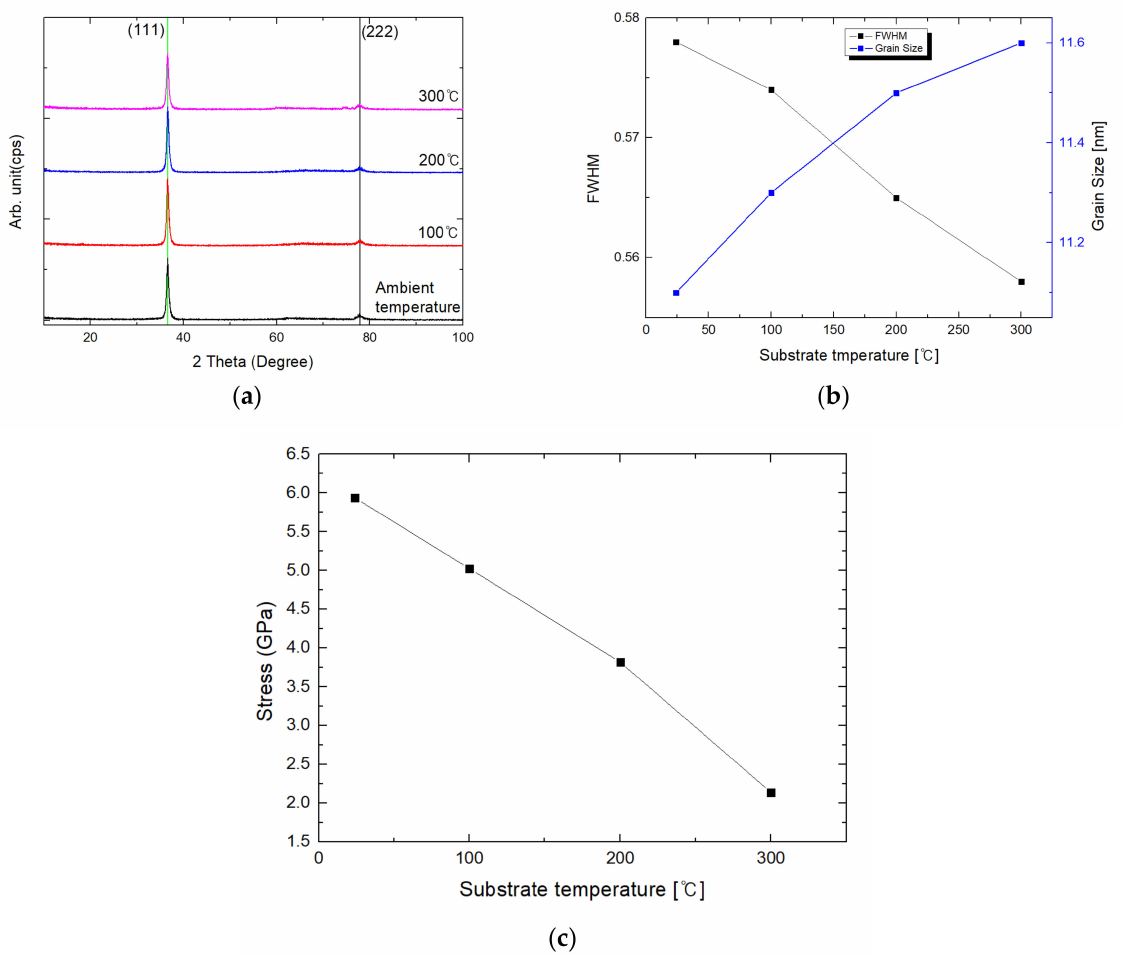
Figure 2. XRD measurement results of the TiN thin film deposition at the varying substrate tempera- ture: ( a ) XRD patterns; ( b ) FWHM and grain size change; ( c ) residual stress